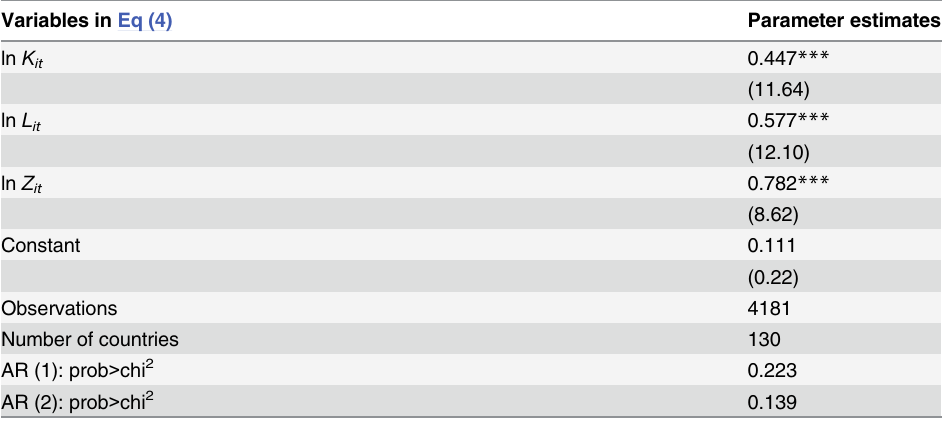
Table 4. Estimates in Growth